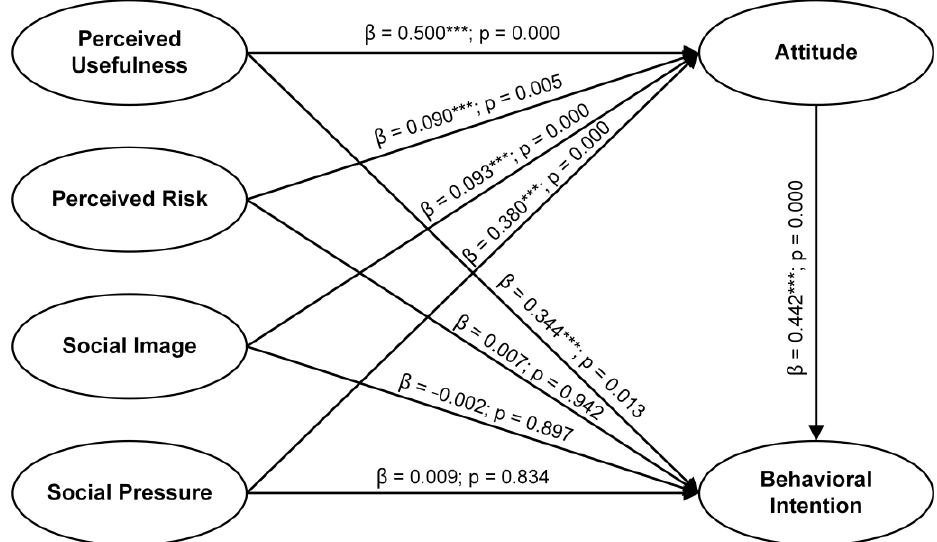
Figure 2. Model Checking Results. Note: Model Fit: CFI = 0.948; GFI = 0.909; NFI = 0.940; SRMR =